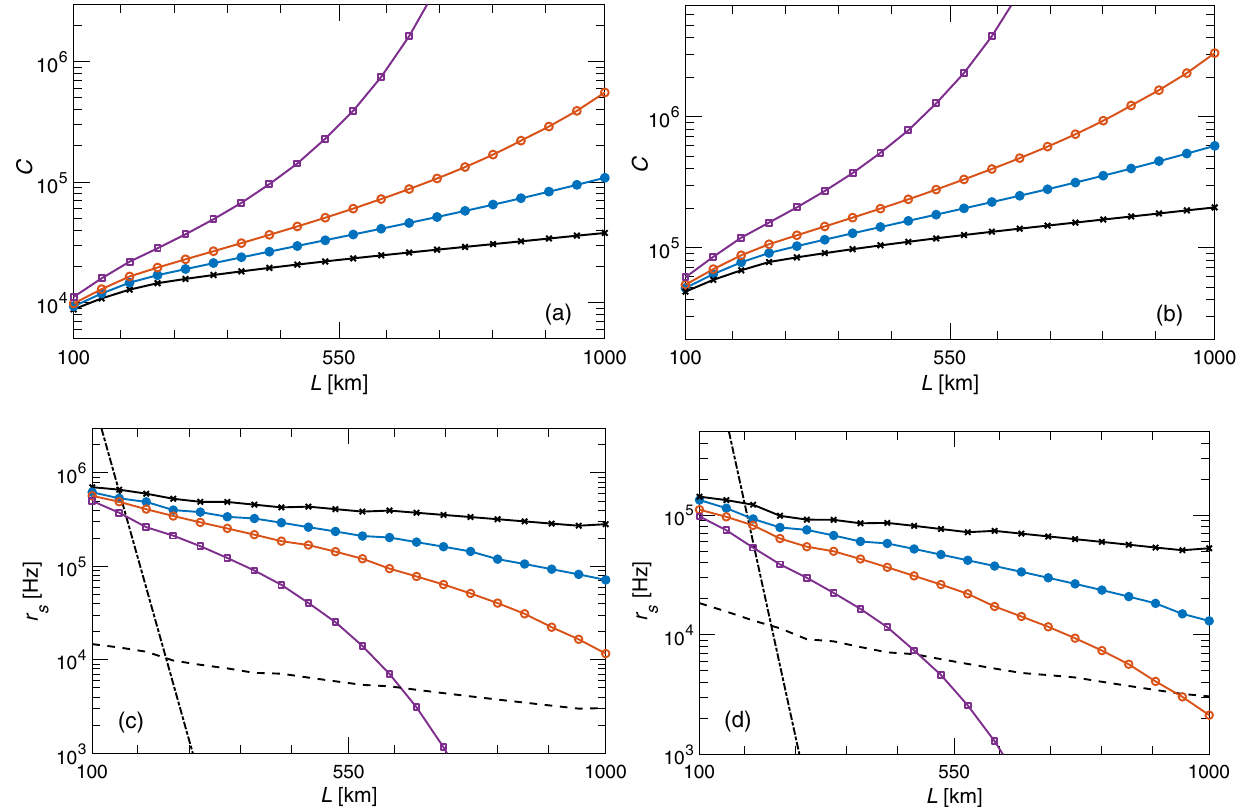
¼ 10 τ FIG. 6. (a),(b) Minimized cost parameter C as a function of distance L assuming spin entangling gate times of τ (a) and CZ ph τ ¼ 100 τ ¼ 0 . 1 ‰ ; filled circle, ϵ ¼ 0 . 3 ‰ ; circle, (b) for tree-cluster state generation. The markers correspond to times symbol, ϵ r r CZ ph ϵ ¼ 0 . 5 ‰ ; square, ϵ ¼ 0 . 1% . Here, ϵ is the error probability of the reencoding operation at the repeater stations. (c),(d) r r r ¼ 1 ns and gate time of τ ¼ 10 ns (c) and τ ¼ 100 ns Corresponding secret bit rate assuming a photon emission time of τ ph CZ CZ (d). We have restricted the minimization to trees with n ≤ 300 photons and repeater station spacings ≥ 1 km. We have assumed a ¼ 95% . For comparison, the secret bit rate of a two-way repeater (dashed line) with similar resources (see detection efficiency of η d main text) is also plotted together with the rate of direct transmission (dot-dashed line) assuming a 1 GHz single-photon